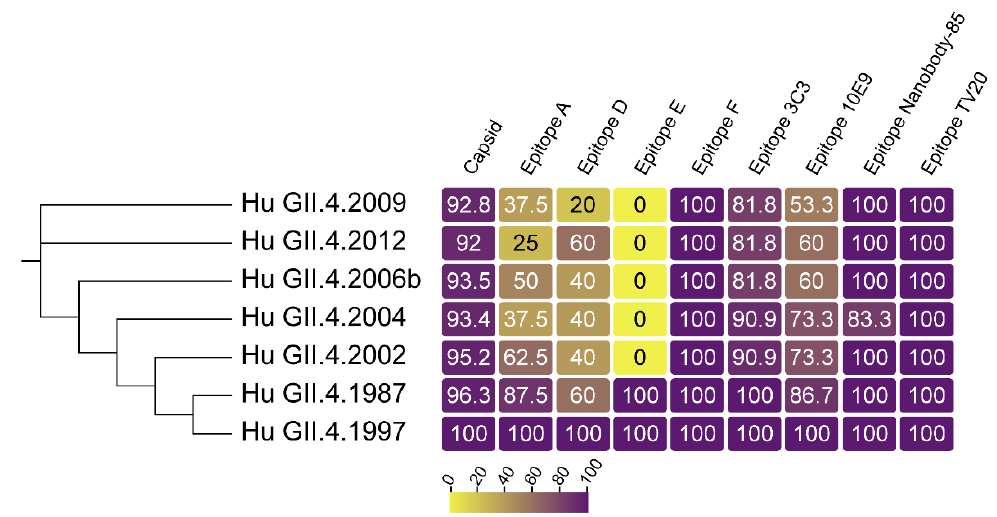
Figure 1. GII.4 VP1 diversity over time. Sequence identity of VP1 (capsid), and known blockade antibody epitopes compared to GII.4 US95/96 (represented by GII.4 1997, AFJ04707.1), the first known GII.4 pandemic strain. GII.4 2002, 2004, 2006b, 2009, and 2012 are sequential pandemic strains, represented by isolates, AAZ31376.2, AFJ04709.1, AEX91909.1, and AFV08794.1, respectively. GII.4 1987 (AAK50355.1) is an endemic GII.4 strain that circulated before GII.4 US95/96 emergence. Overall identity within VP1 is high. Identity within the known evolving blockade antibody epitopes is less well conserved, resulting in the emergence of new pandemic strains refractive to herd immunity shaped by previous GII.4 exposure. Epitopes conserved between GII (epitope nanobody-85) and GI/GII strains (epitope TV20) remain largely unchanged over time in GII.4 strains.